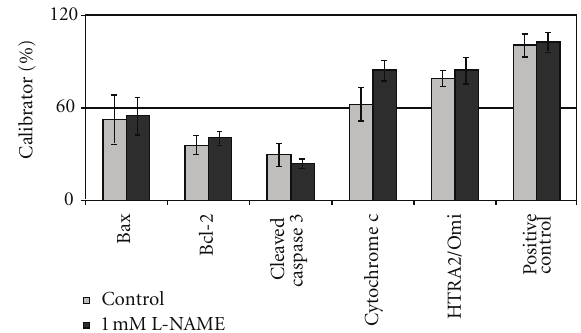
Figure 3: Change in concentration of apoptosis-related proteins after treatment with L-NAME. Bars display the change in concen- tration of Bax, Bcl-2, cleaved caspase 3, cytochrome c, HTRA2/Omi, and the positive control after treatment of HAECs with 1mM L-NAME for